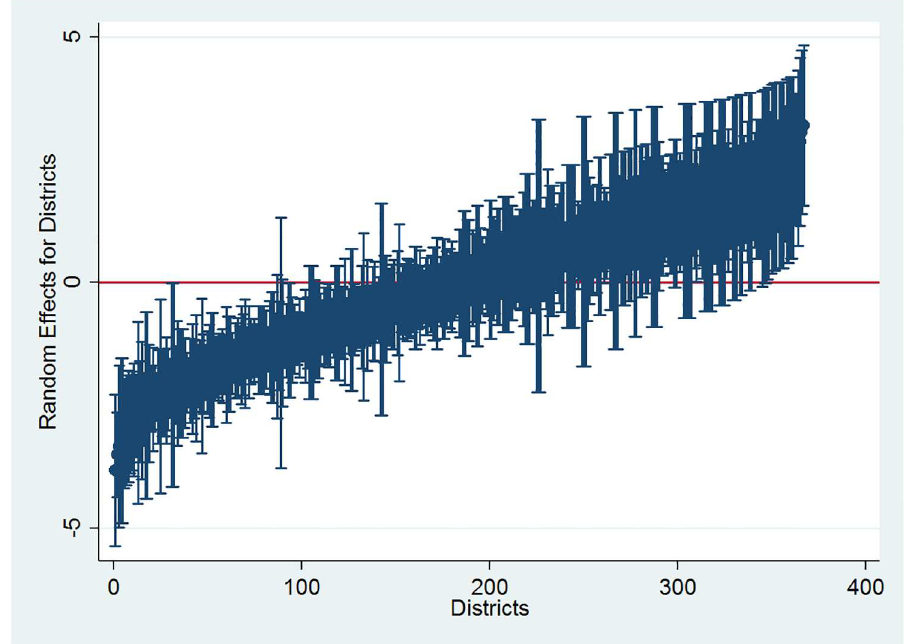
Fig 1. District level differences in birth registration